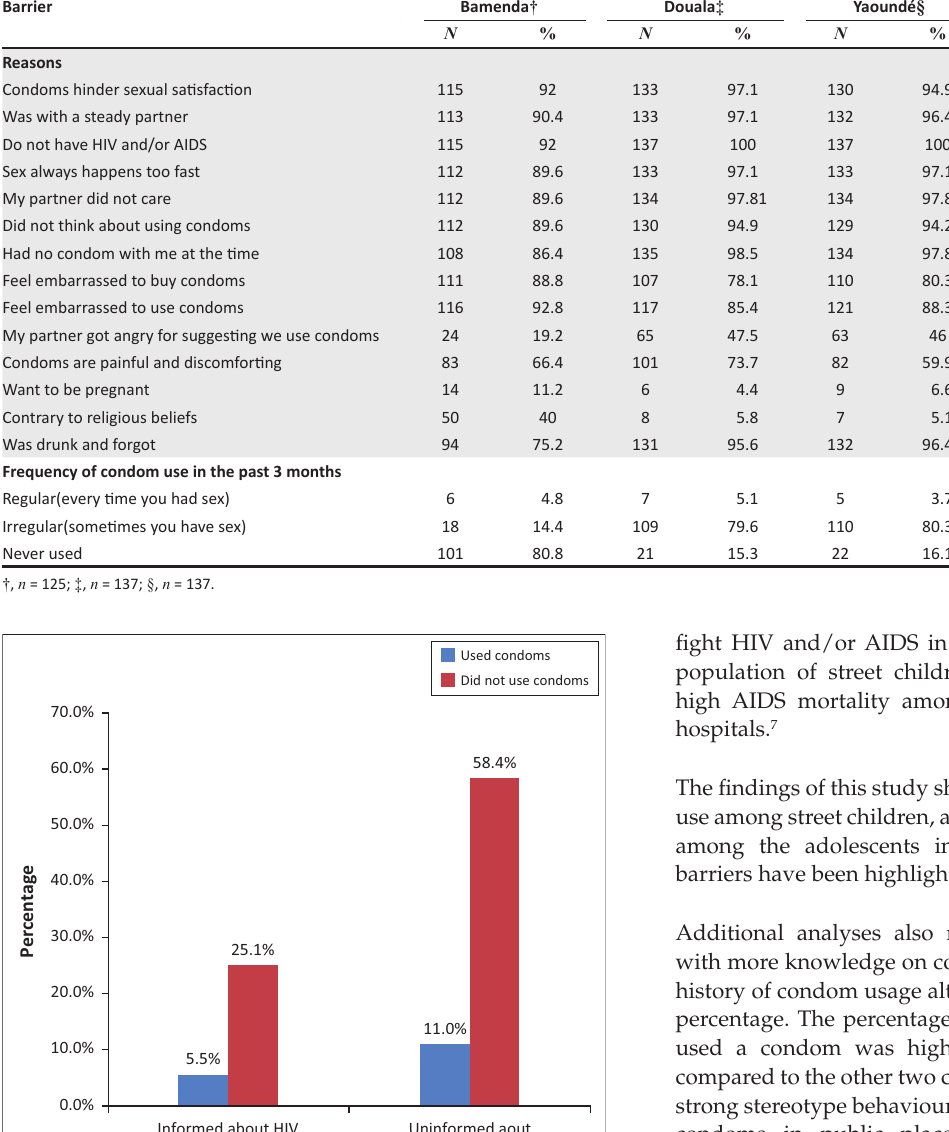
TABLE 3: Perceived barriers to condom use.